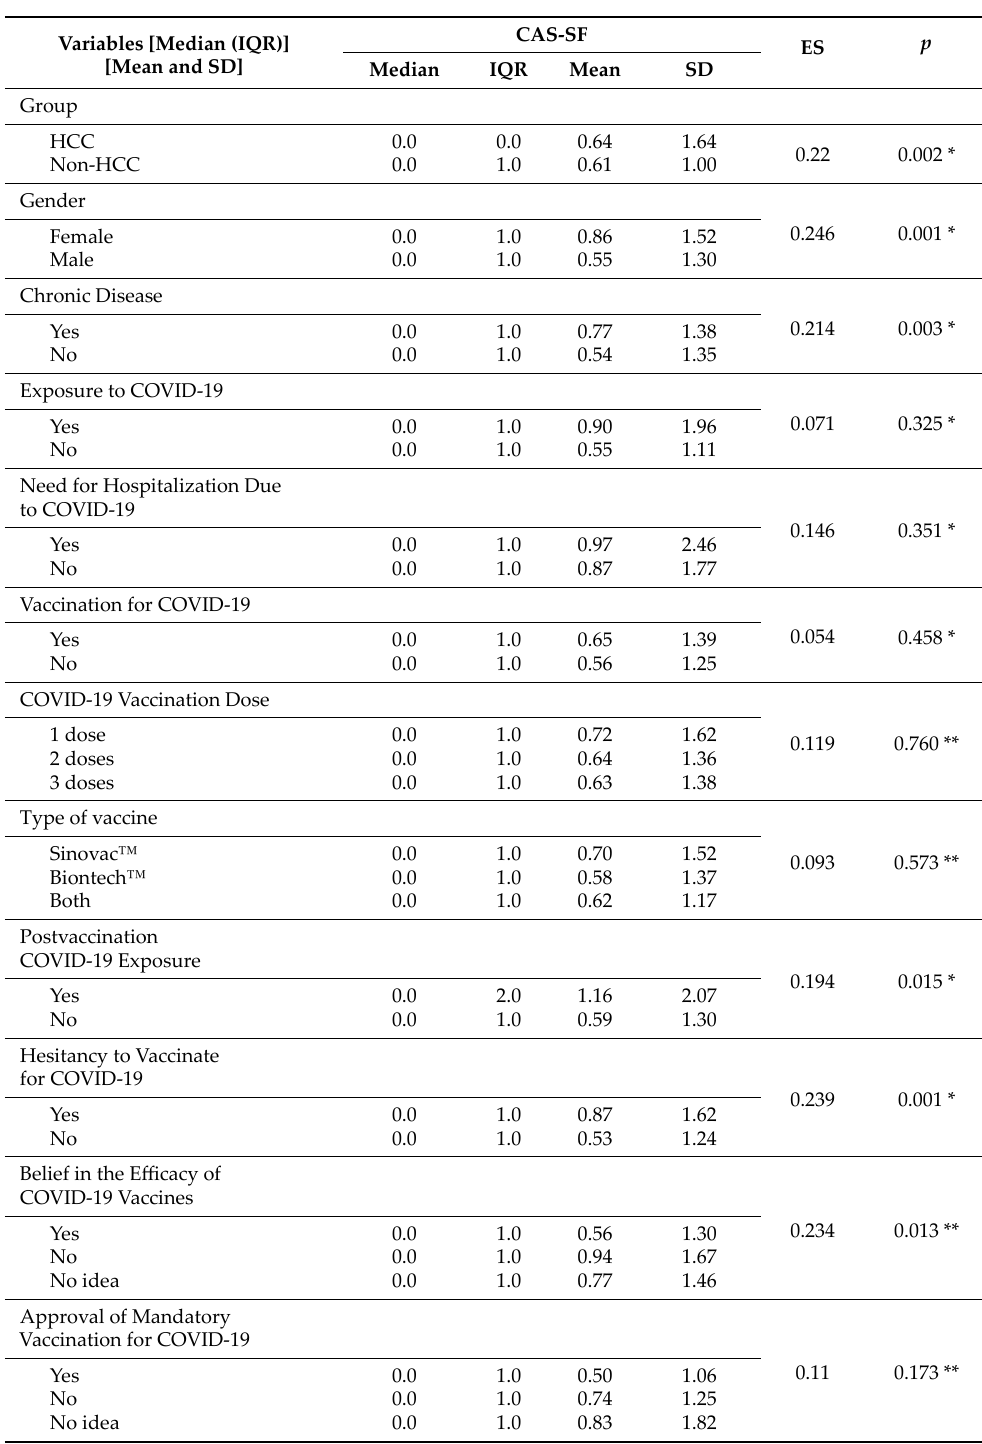
Table 4. Comparison of some independent variables according to CAS‑SF scores. Variables [Median (IQR)] [Mean and